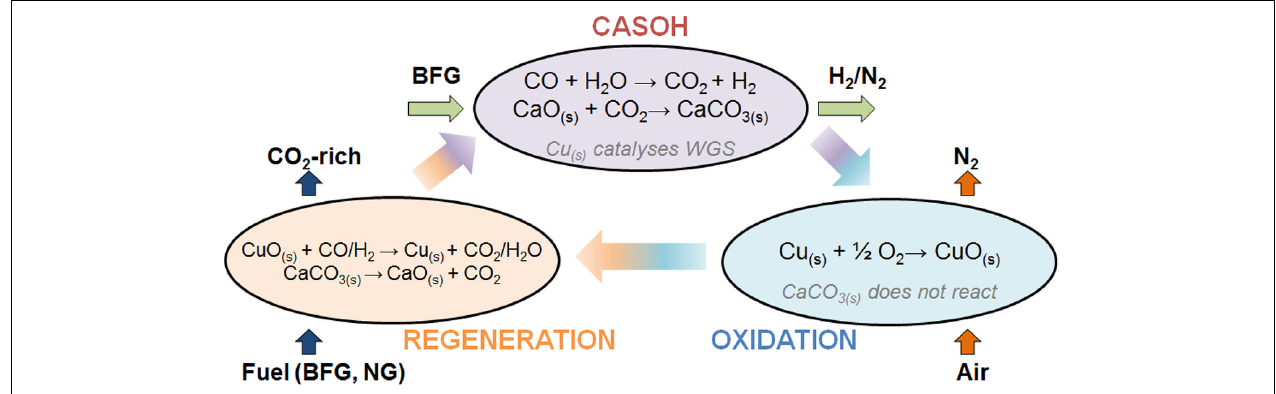
FIGURE 1 | Scheme of the Ca-Cu chemical looping process for the production of H 2 -rich gas from BFG and CO 2 ready for storage or reutilization.